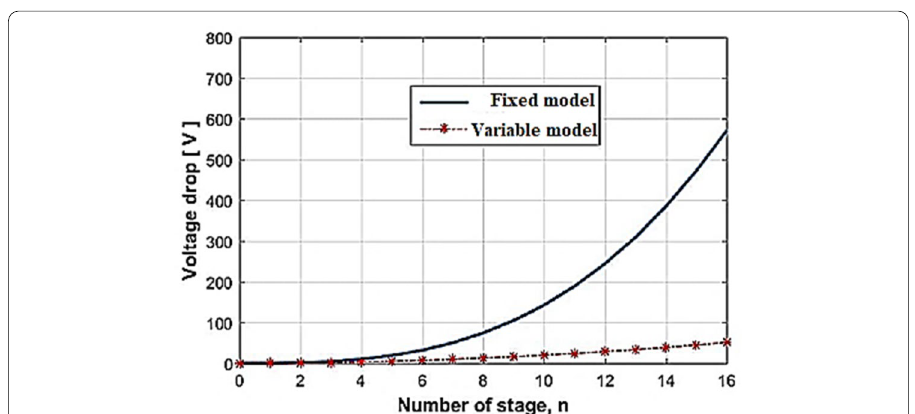
Fig. 5 Variation of Voltage Drop for a fixed